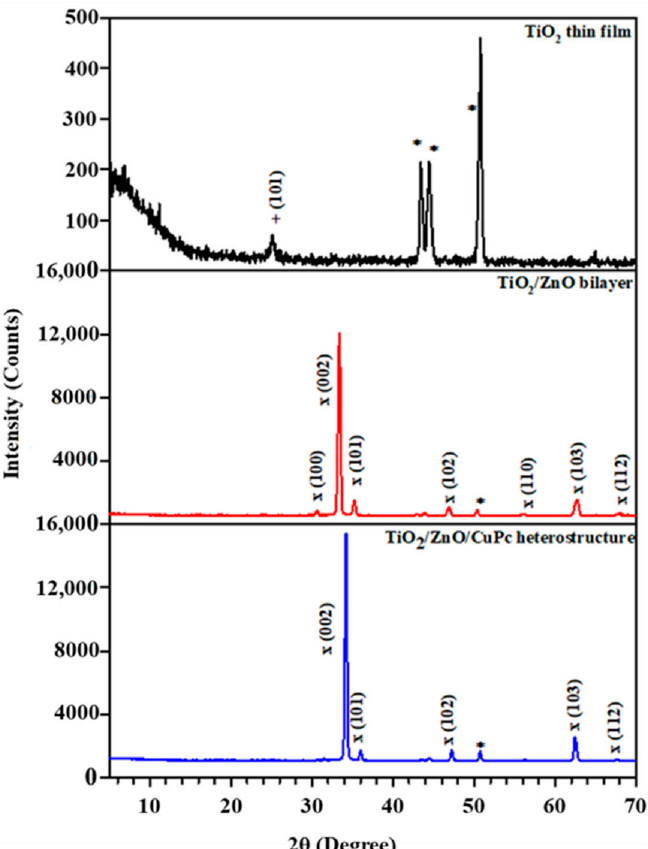
Figure 2. XRD patterns of TiO 2 thin film (black line), TiO 2 /ZnO bilayer (red line), and TiO 2 /ZnO/ CuPc layered structure (blue line) on stainless steel substrates (Peaks *: substrate; +: TiO 2 anatase; x: